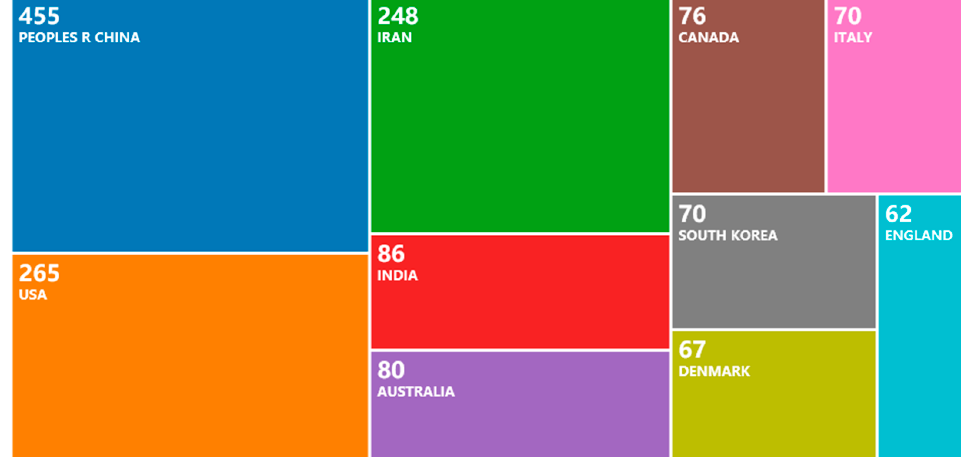
Figure 8. Dendrogram of publishing country.